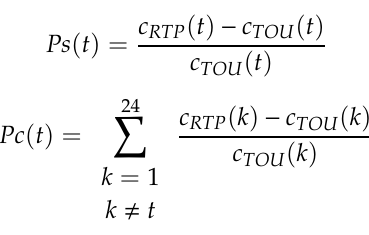
Table 4. Self- and cross-elasticity coe ffi cients for each configuration.